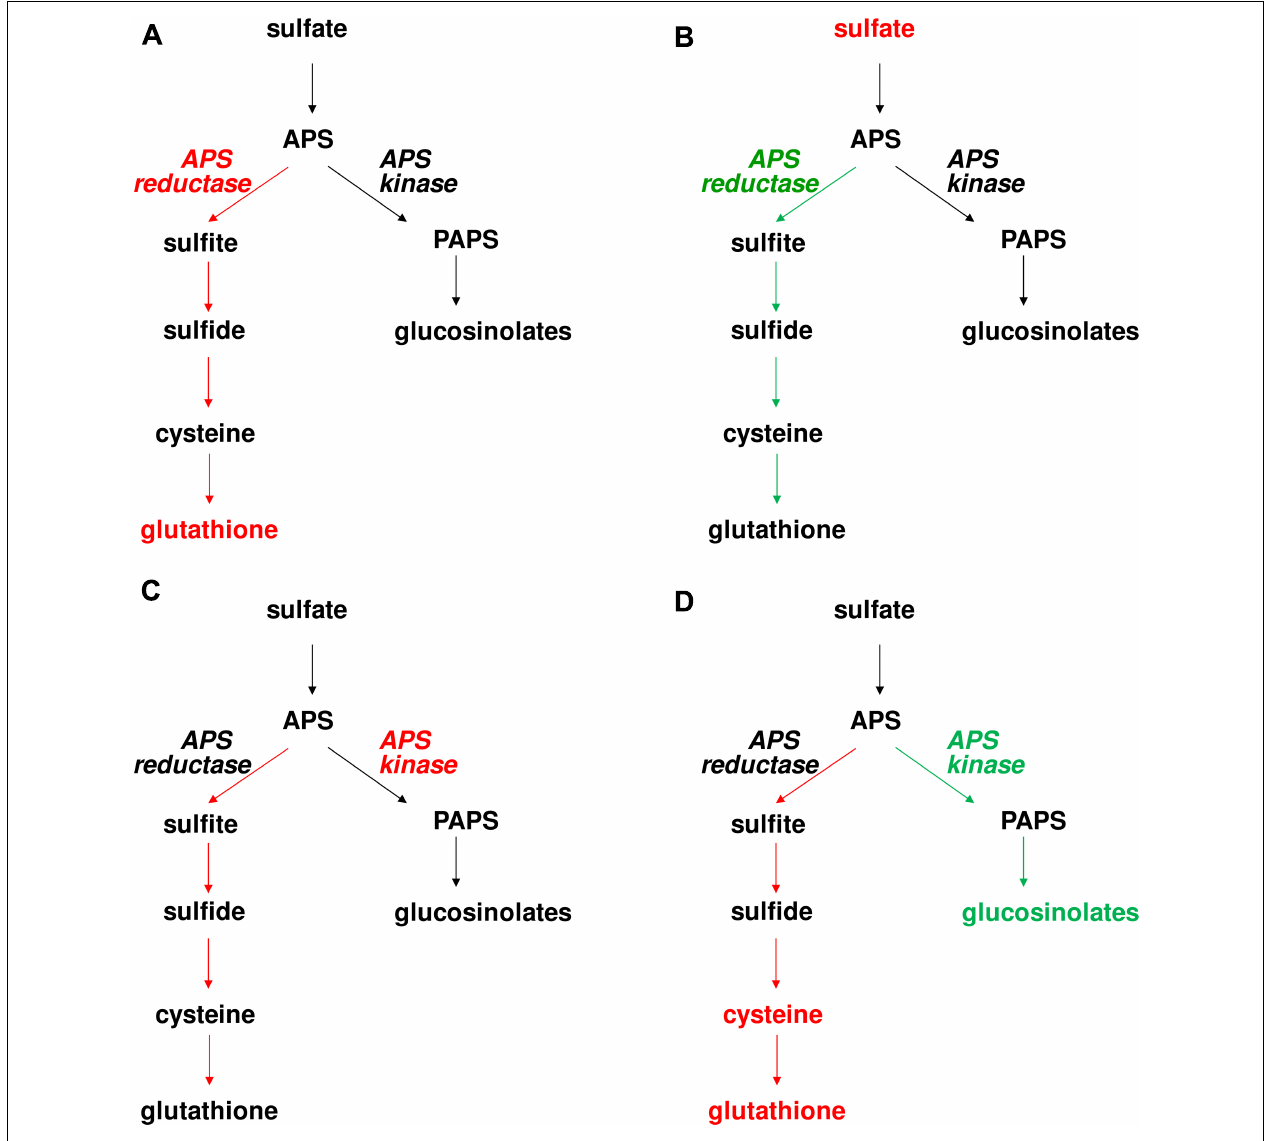
FIGURE 2 | Effects of manipulation ofAPS reductase andAPS kinase on levels of S-containing compounds and flux through the pathway in Arabidopsis . Red and green colors symbolize increased and decreased